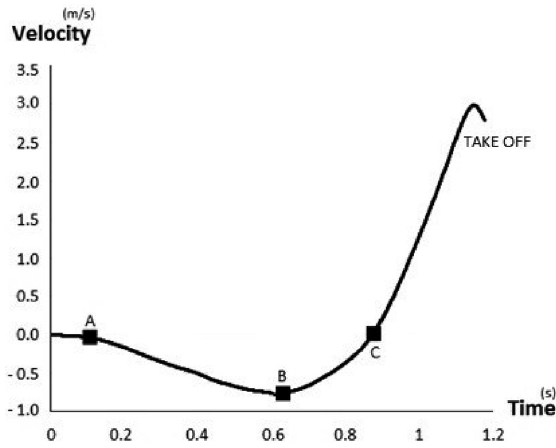
Figure 1. CMJ phases according to the velocity-time curve: (A) onset of the unweighting phase, (B) onset of the eccentric phase, and (C) onset of the concen- tric phase.